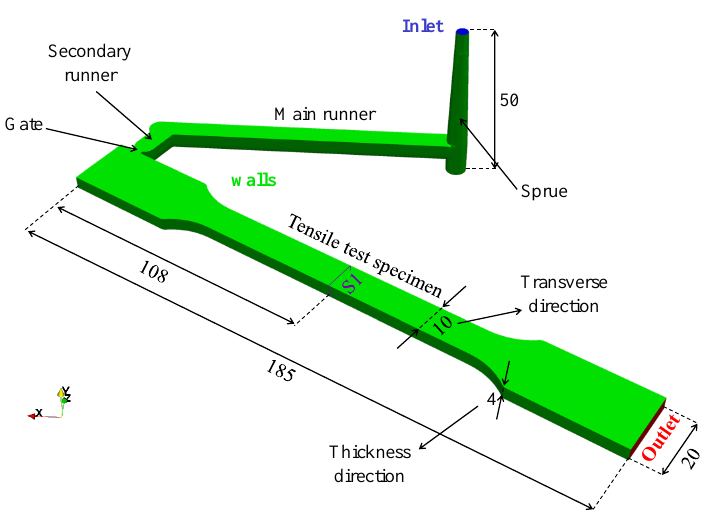
Figure 8. Geometry and boundary walls for Case Study 3 (dimensions in mm).